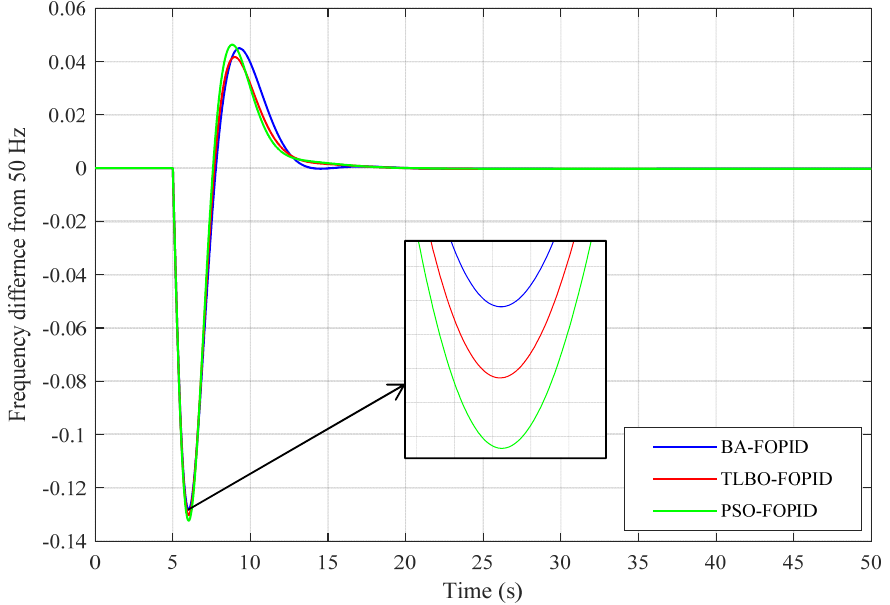
Figure 9. Change in frequency in the GB power system for 0.035 pu load disturbance with tuned FOPID-based ITAE.